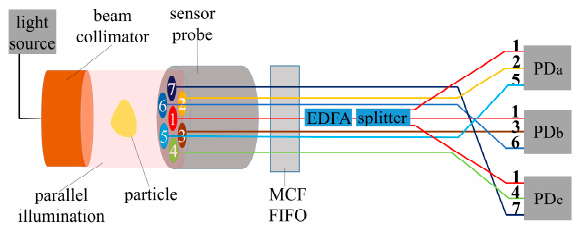
Figure 4. Experimental setup for two-dimensional particle velocity measurement by using MCF. MCF FIFO: MCF fan in fan out; EDFA: erbium doped fiber amplifiers; PD: photo